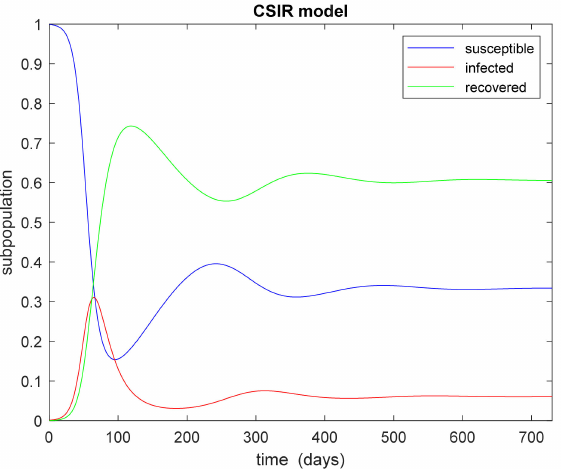
Figure 7. Typical dynamics of the CSIR for the following constant rates α = 0.18, β = 0.06, γ = 0.006